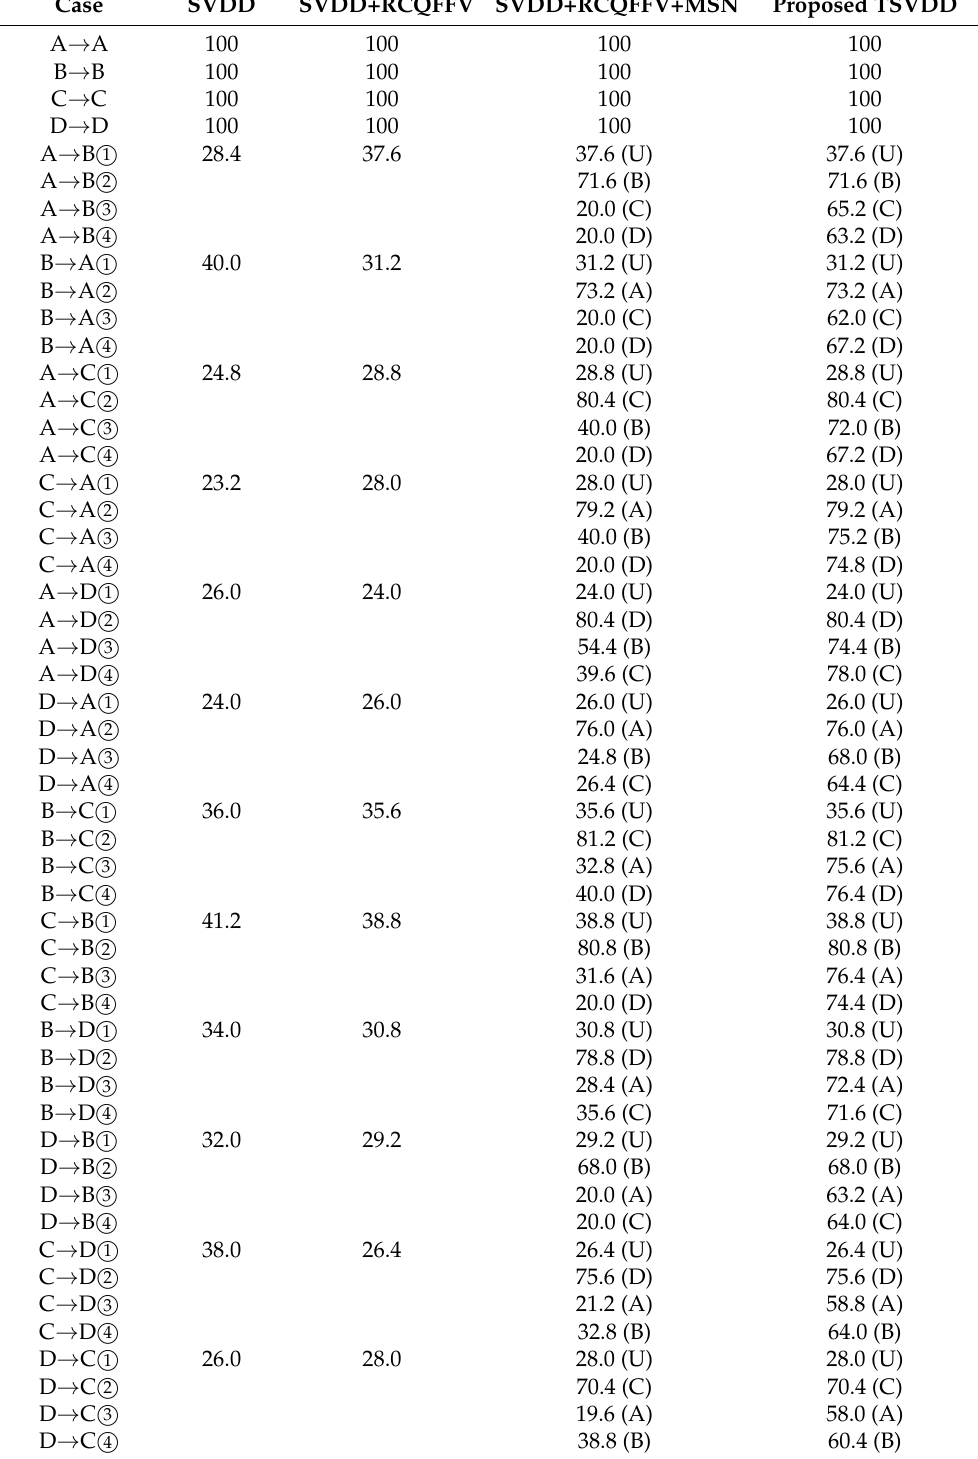
Table 2. Diagnosis performance for the proposed TSVDD and other